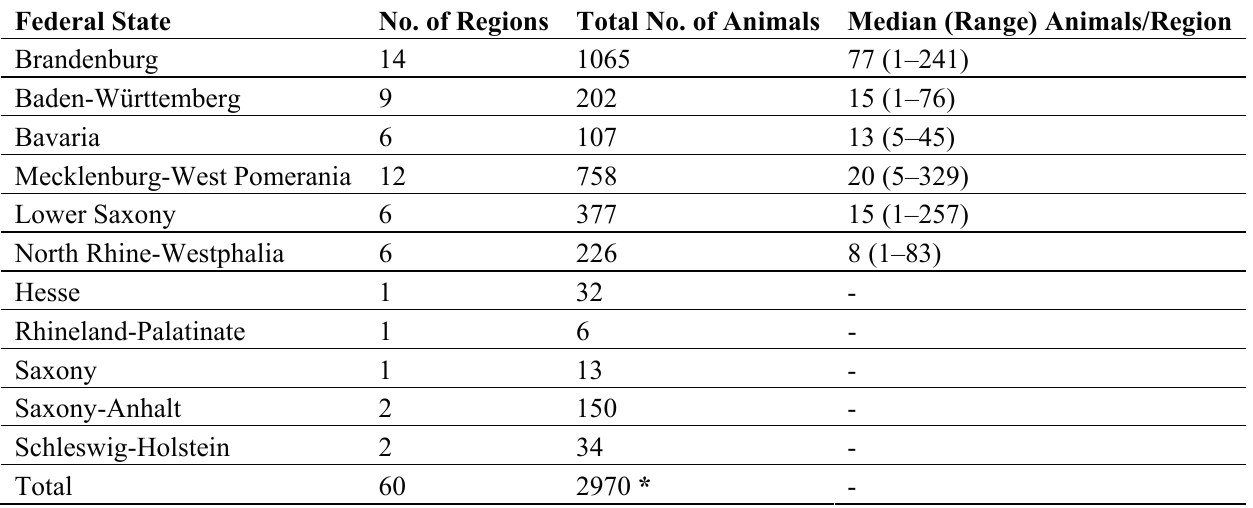
Table 1. Number of animals trapped per federal state and